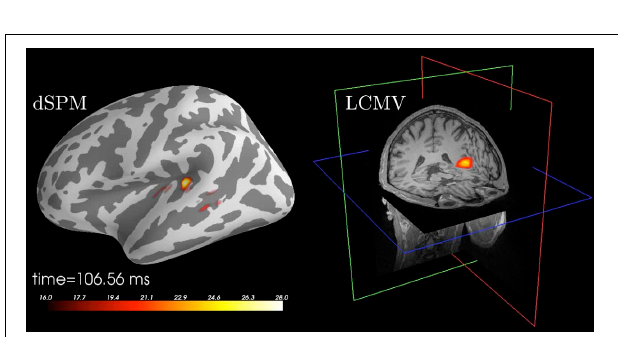
FIGURE 3 | Cortical segmentation used for the source space in the distributed model with MNE. Left: The pial (red) and white matter (green) surfaces overlaid on an MRI slice. Right: The right-hemisphere part of the source space (yellow dots), represented on the inflated surface of the left hemisphere, was obtained by subdivision of an icosahedron leading to 10242 locations per hemisphere with an average nearest-neighbor distance of 3.1mm. Left image was produced with FreeSurfer tksurfer tool and the right one with PySurfer (http://pysurfer.github.io) which internally depends on Mayavi (Ramachandran and Varoquaux, 2010).